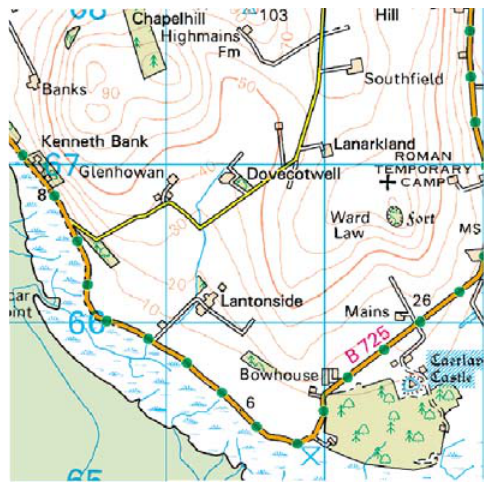
Fig 3b. Topographic map of Caerlaverock – an area of salt-marsh and pasture, without steep slopes.